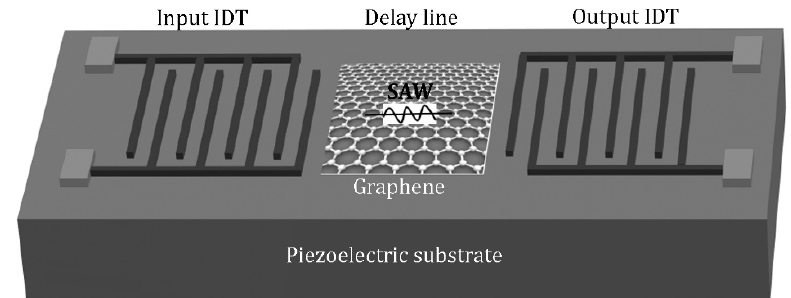
Figure 3. Schematic diagram for a graphene-based surface acoustic wave sensor.